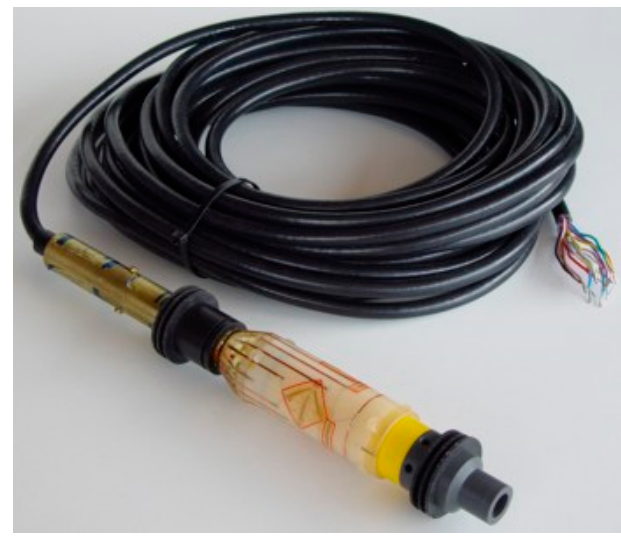
Figure 4. CSIRO HI test probe. Table 1. Parameters of horizontal stress fields at the Polkowice-Sieroszowice mine [16,26]. Measurement Test